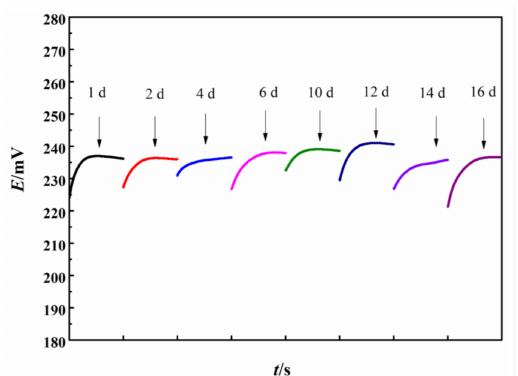
Figure 7. The OCP potential measured using the same Fc-CPE in 3.5 wt.% NaCl containing 10 mg · dm − 3 TRC, on different days.